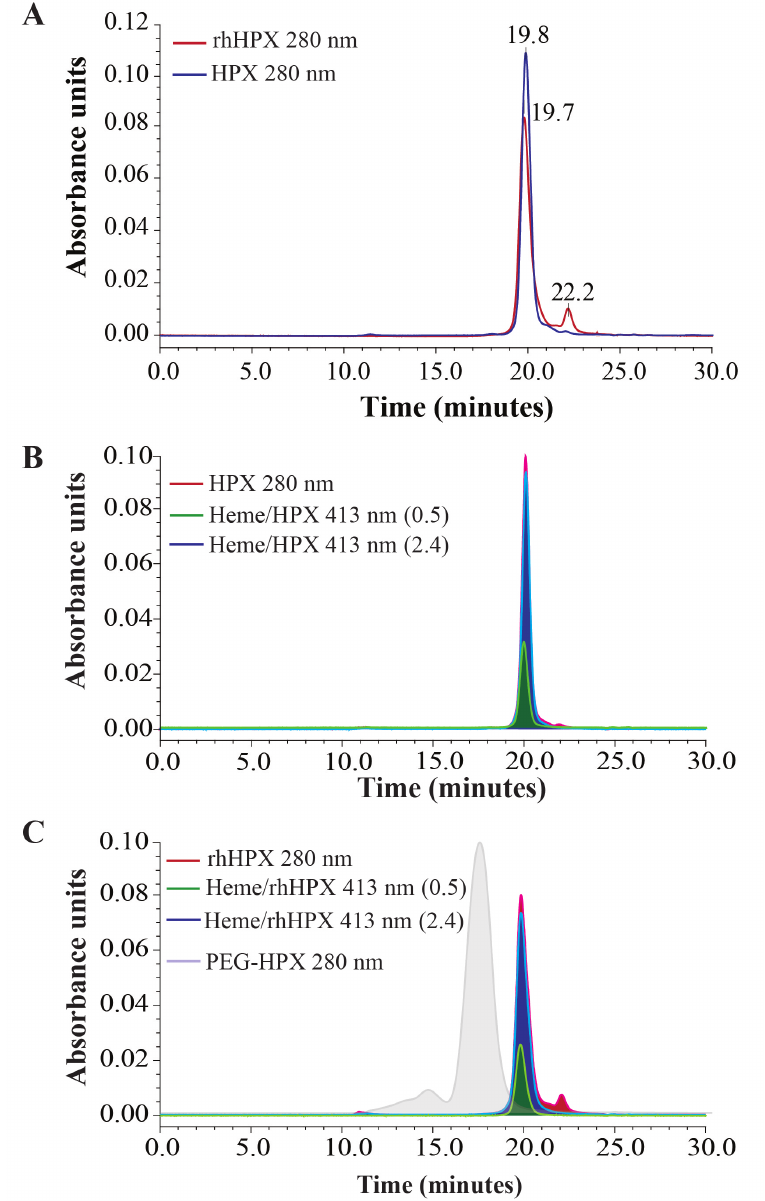
Figure 8. SEC-HPLC assessment: ( A ) Apo-proteins rhHPX and HPX; ( B ) HPX/Heme samples at an L/P of 0.5 and 2.0 vs. HPX; ( C ) Heme complexes with rhHPX (L/P of 0.5 and 2.0) vs. rhHPX and PEG-HPX. Detection of the peaks was performed at 280 nm and 413 nm as specified on the plots. According to the crystal structure, heme binds to HPX in a bis-histidine hexa-coordinated ligation mode being captured between His-213 and His-226 residues. The possibility